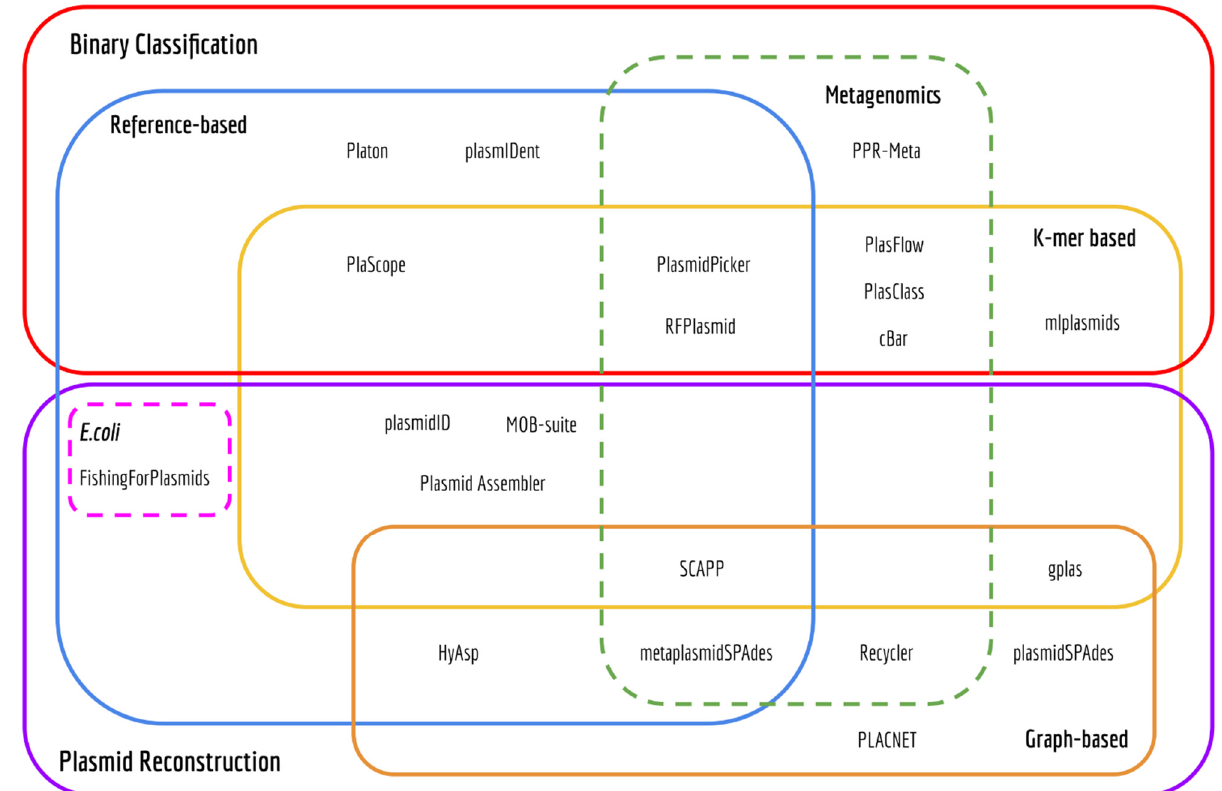
Figure 1. Euler diagram of bioinformatics tools to predict the plasmidome of bacteria.